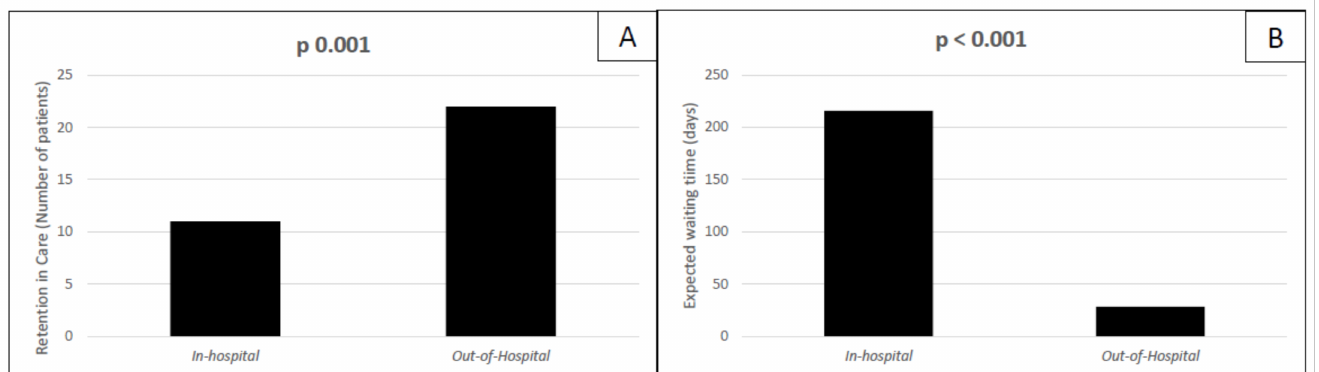
Figure 2. Patients treated with DAAs in our population. Retention in care rates among patients treated for HCV in hospital and out of hospital Panel ( A ); expected days of waiting before DAAs treatment start in the standard in-hospital setting group and in the out-of-hospital setting group panel ( B ). Table 3. Comparison of primary and secondary outcomes between in-hospital and out-of-hospital settings.